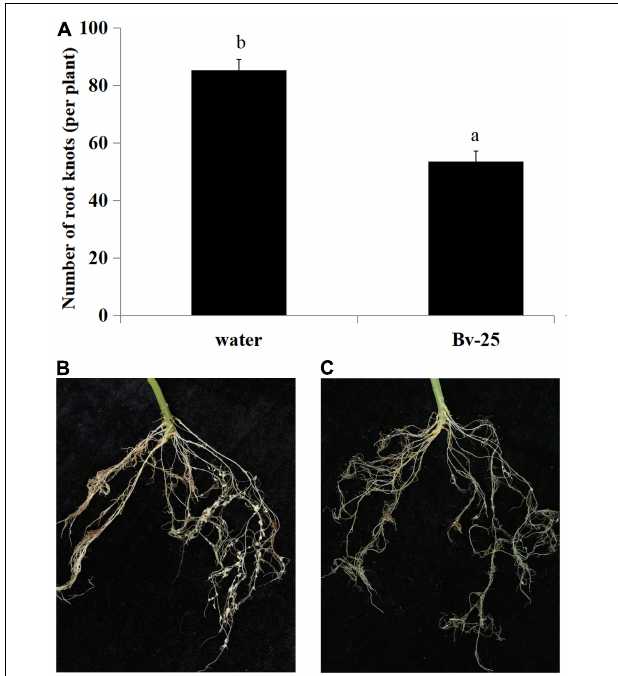
FIGURE 6 | Suppression of M. incognita infection by strain Bv-25. (A) Number of root galls on cucumber seedlings treated with Bv-25 or water. (B) Root galls on cucumber seedling treated with water. (C) Root galls on cucumber seedling treated with Bv-25. Different letters indicate significant differences ( p < 0.05; n = 30) between treatments according to Duncan multiple-range test following one-way